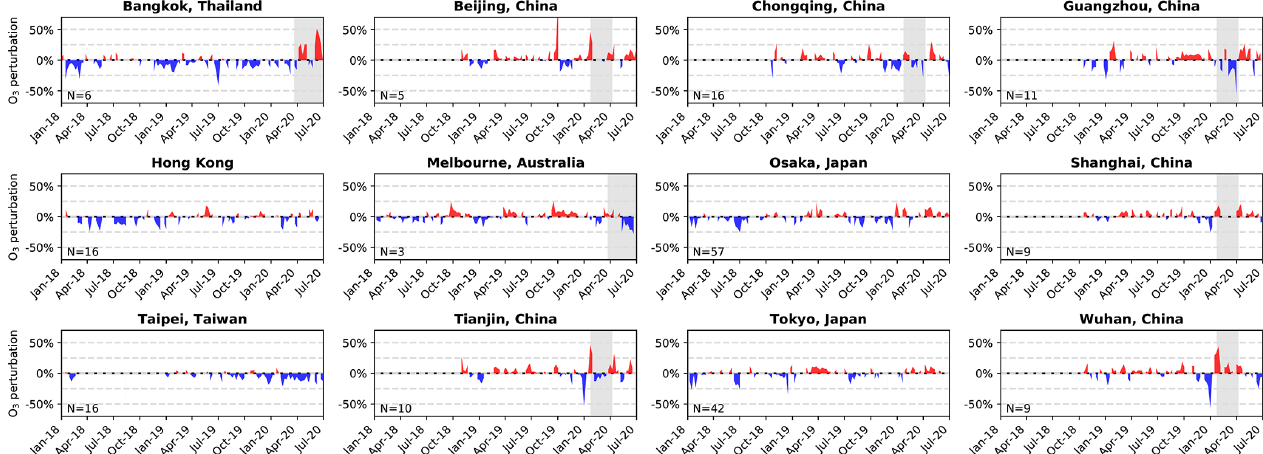
Figure A9. Normalized fractional O 3 perturbations (observation–bias-corrected model, normalized by the bias-corrected model prediction) from 1 January 2018 through June 2020 for selected cities in Asia and Australia. Grey-shaded areas indicate COVID-19 lockdown periods. Number of sites per city are shown in the bottom left of each